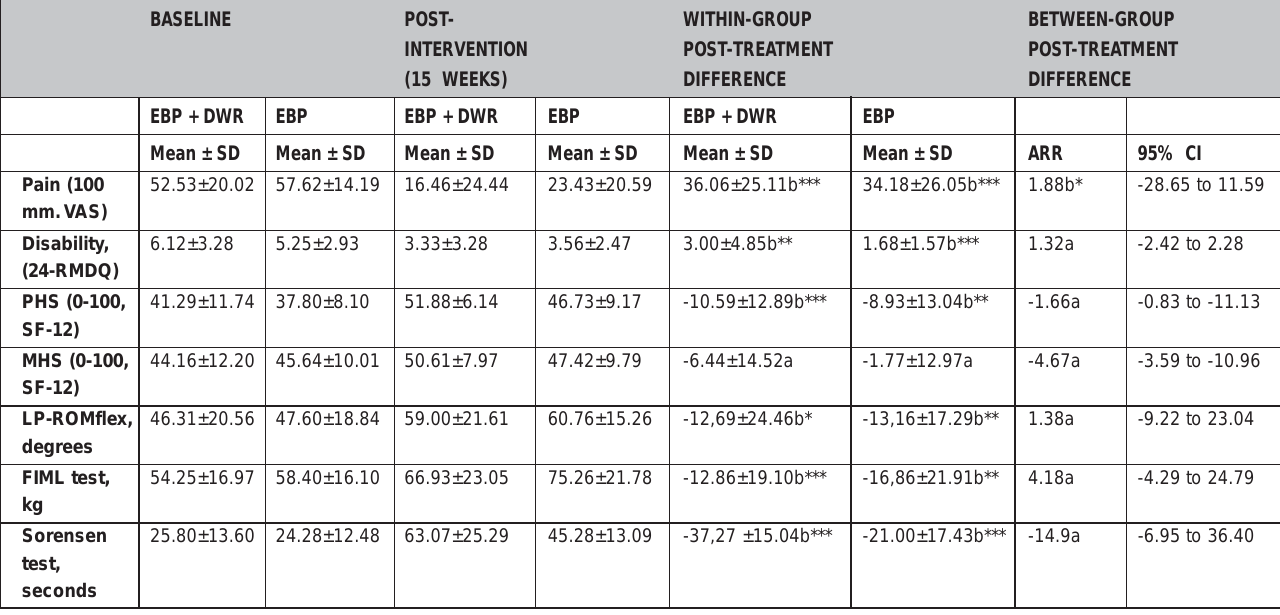
Table 2. Score according to group and time and changes within-group and between